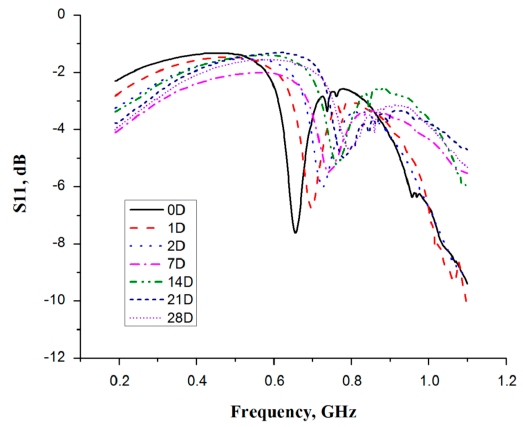
Figure 7. Resonance frequency observed for the meat stored up to four weeks (D =